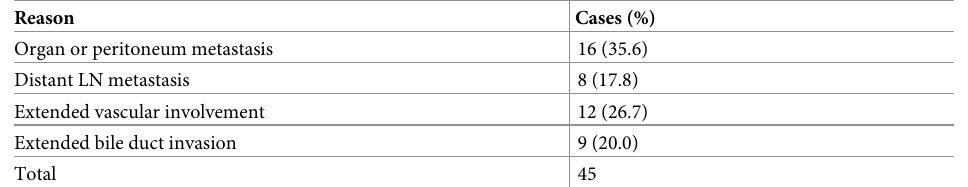
Table 3. Reasons of unresectability judgement after